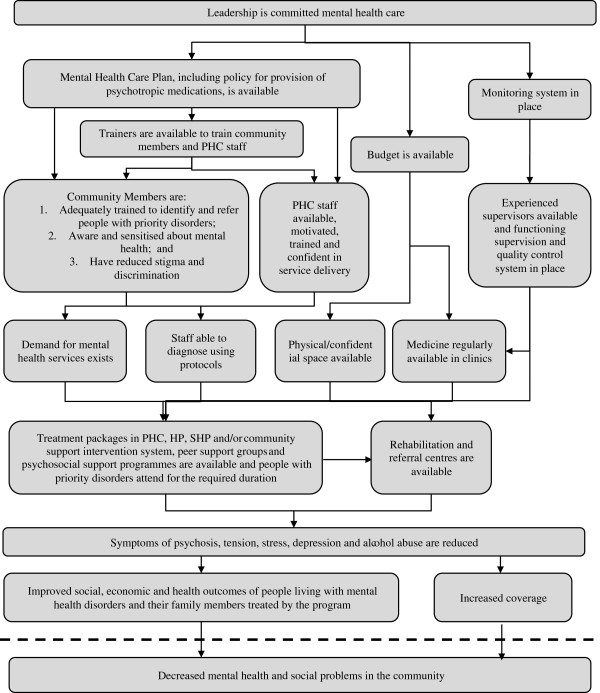
Theory of change.